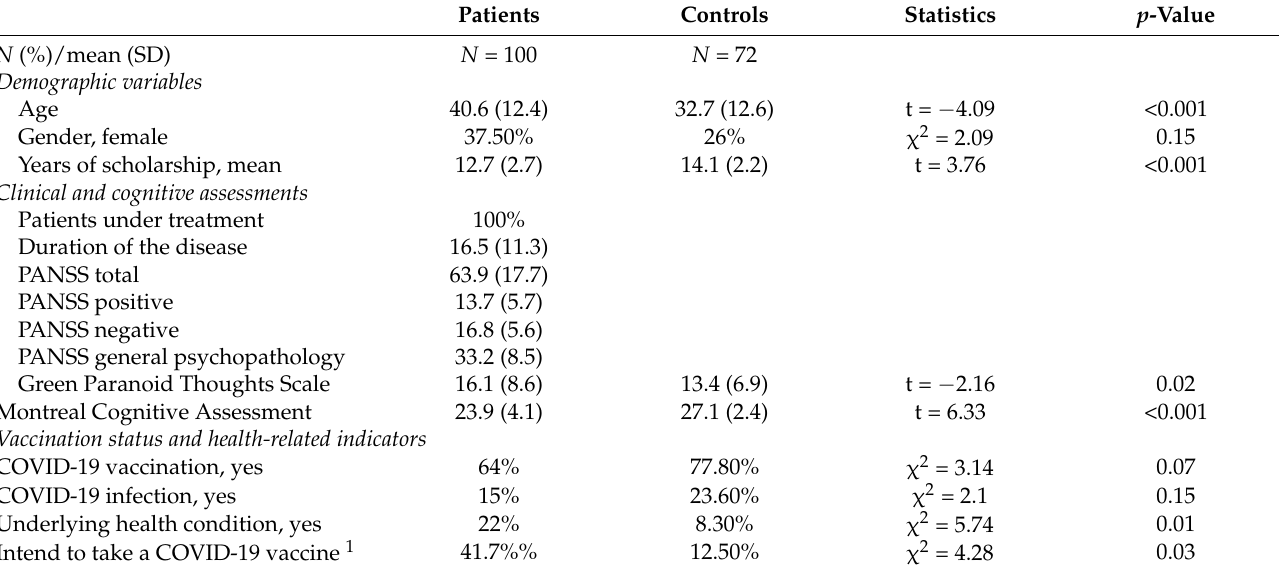
Table 1. Sociodemographic and clinical characteristics of the